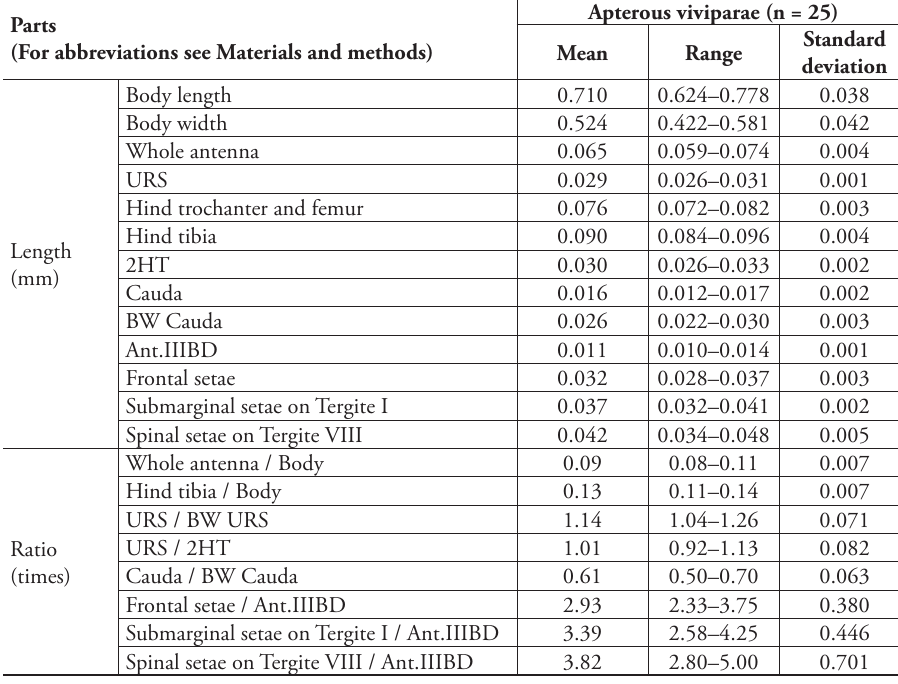
Table 1. Morphometric data of Parathoracaphis spinapilosa sp. n.